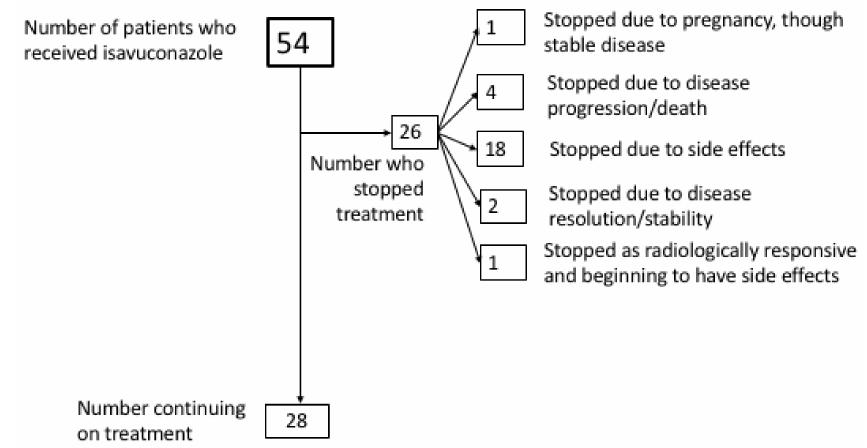
Figure 3. Outcomes of individuals treated with isavuconazole for chronic pulmonary fungal disease throughout the study period ( n =